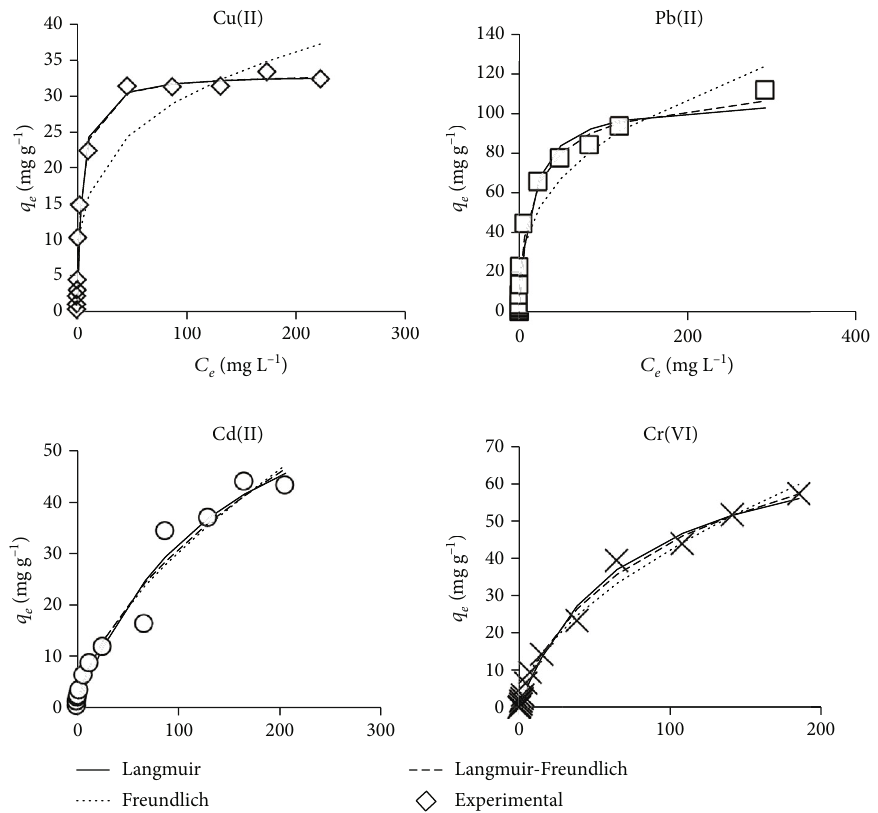
Figure 4: Adsorption isotherms of Cd(II), Cu(II), and Pb(II) at pH = 5 : 4 and Cr(VI) ( pH = 2